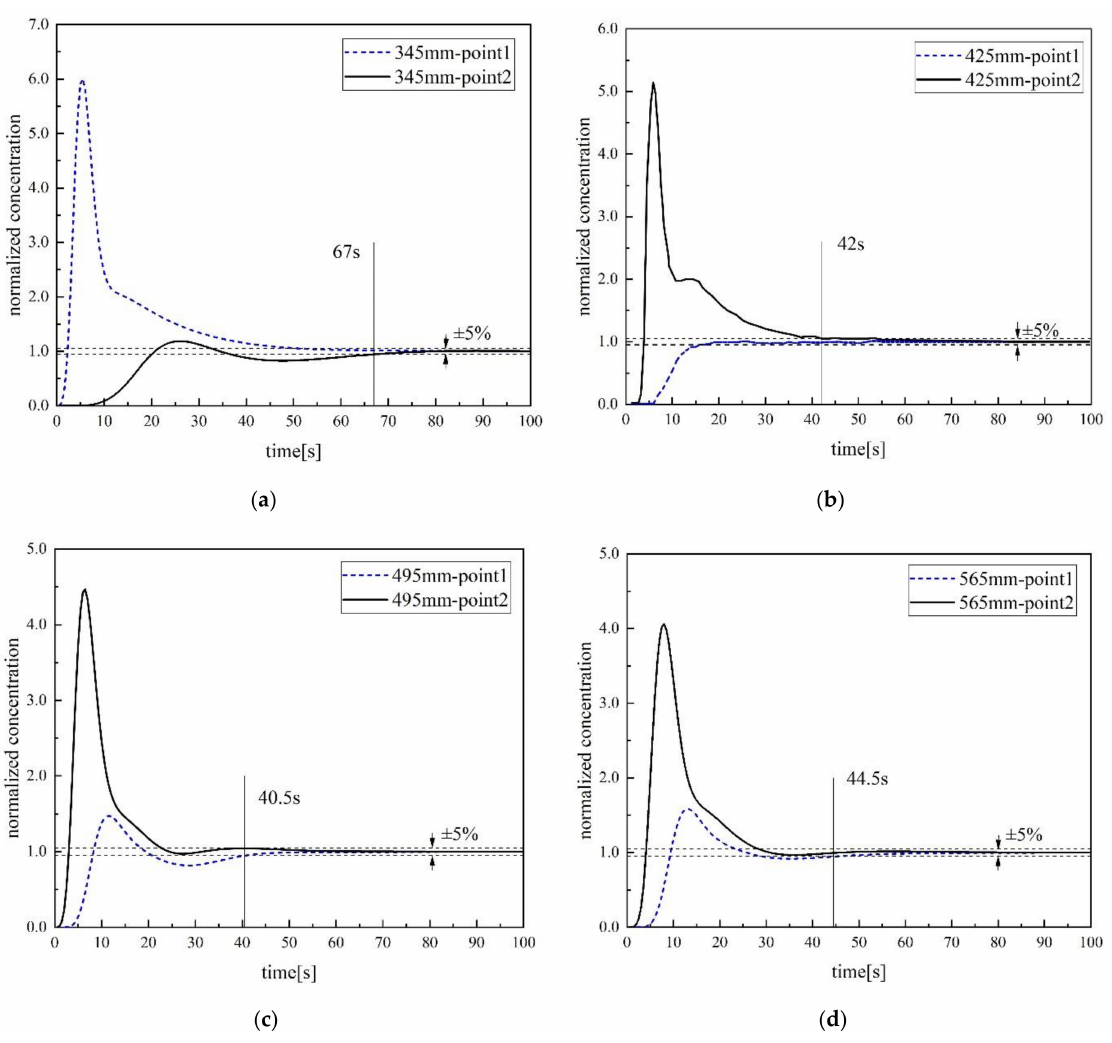
Figure 12. Normalized concentration changing with time at different diameter of single snorkel; ( a ) 345 mm; ( b ) 425 mm; ( c ) 495 mm; ( d ) 565